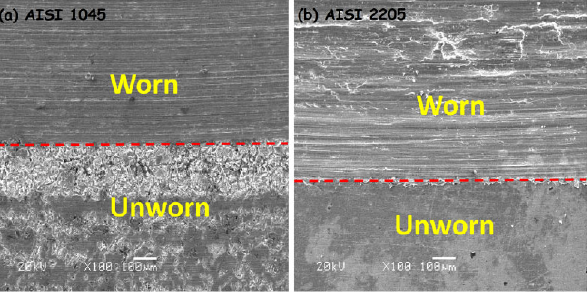
Fig. 3 SEM micrographs of the worn surfaces for (a) AISI 1045 and (b) AISI 2205 after tribocorrosion tests at OCP in